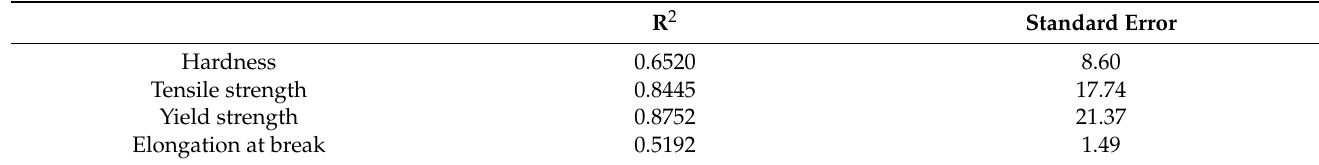
Table 5. Coefficient of determination and standard error for the regression